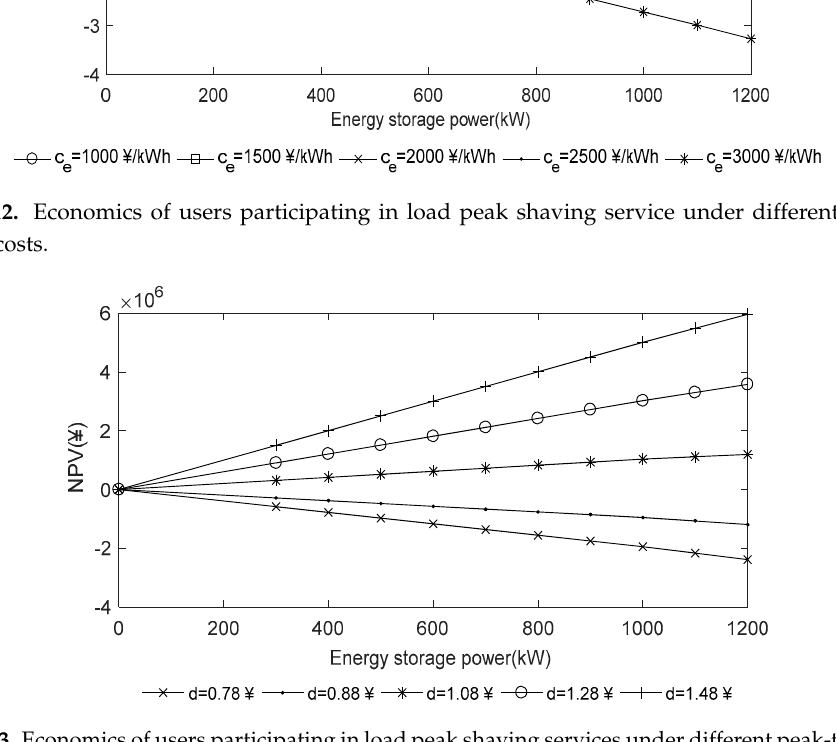
Figure 13. Economics of users participating in load peak shaving services under different peak-to-valley electricity price.